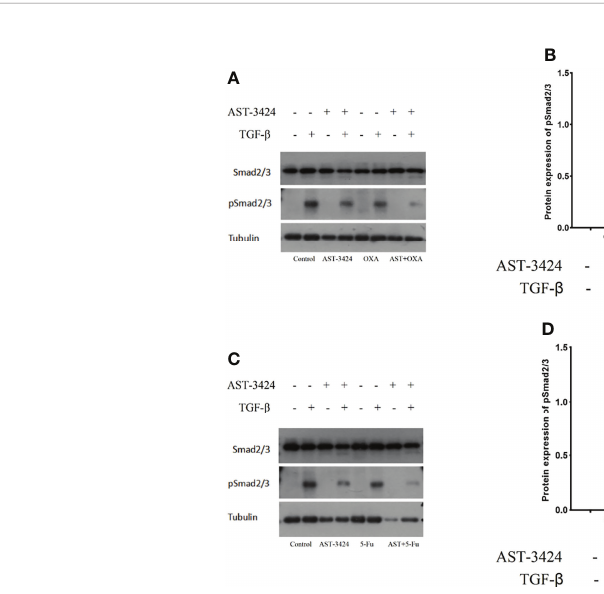
FIGURE 5 | AST-3424 synergized with OXA promoting inhibition in HepG2 cells. p-Smad2/3 protein expression was detected using Western blot after 48 h of treatment with AST-3424 and OXA or 5-Fu alone or in combination with AST-3424 and 4 h of exposure to TGF- b (A – D) . The relative optical density of the proteins was analyzed by ImageJ. All results are expressed as mean ± SEM of three independent experiments. * p < 0.05, ** p < 0.01, *** p < 0.001, compared to the control group; # p < 0.05, ### p < 0.01, ### p < 0.001, the combination group compared to the AST-3424 monotherapy